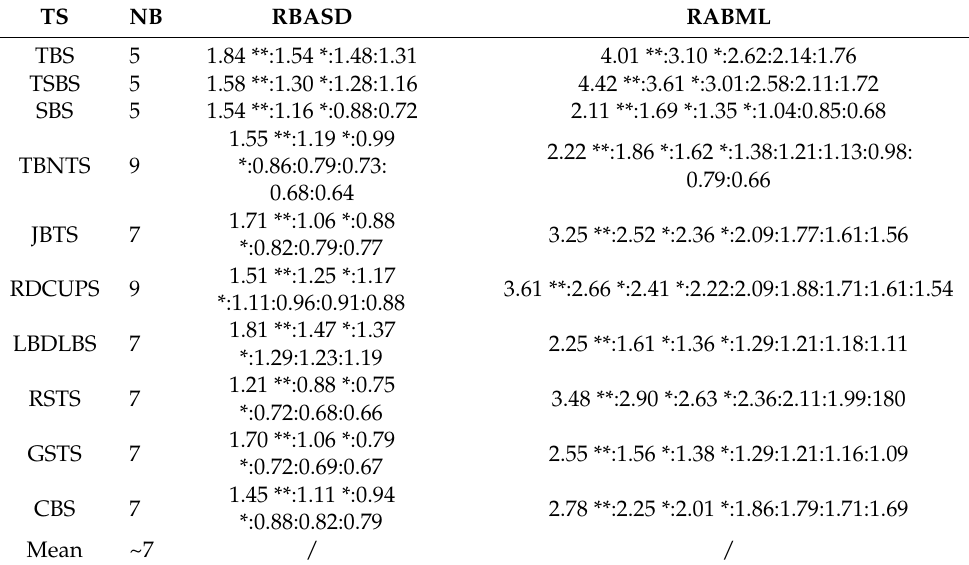
Table 4. Length ratio of the adjacent branch